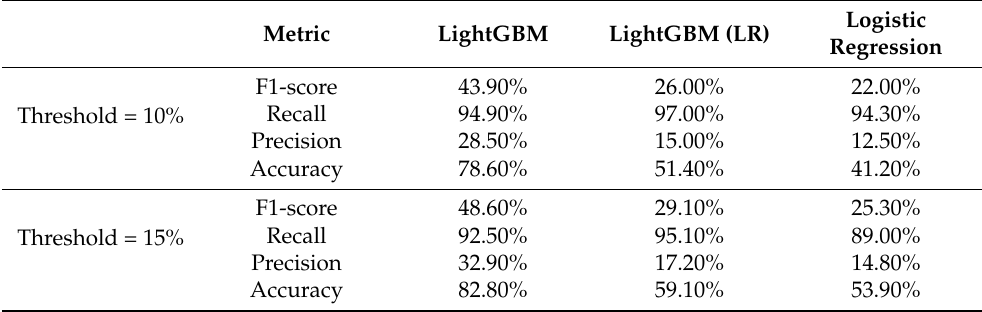
Table 4. Metrics for the three models that were trained. LightGBM was trained with 18 features, whereas LightGBM (LR) was used for directly comparing Logistic Regression with LightGBM using the same six